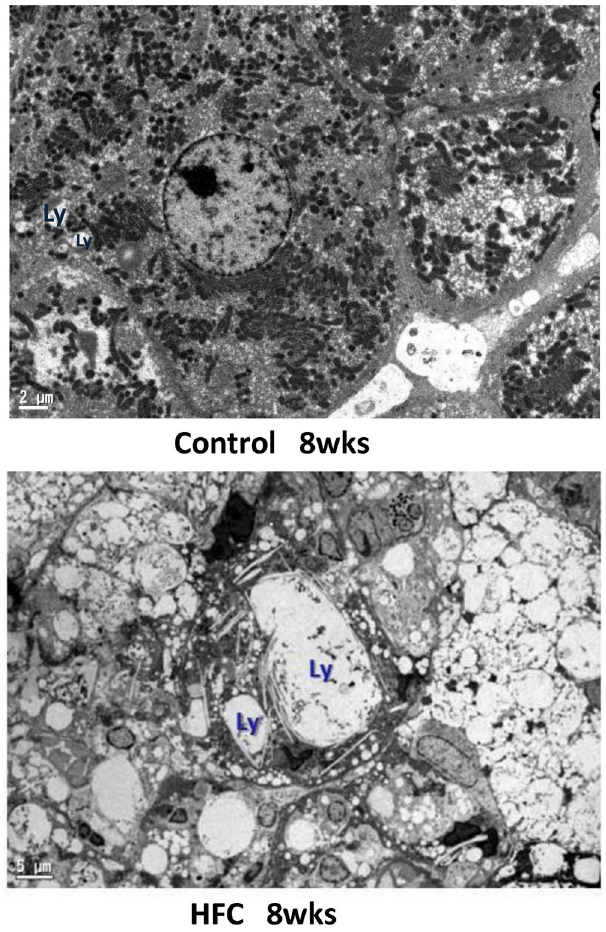
Figure 3. Electron microscopic image. Giant lysosomes ( arrow ) and accumulation of autophagosomes (top- right), related to autologous cells with heterochromatin that adhered to the nuclear membrane, are seen in the livers of rats fed the HFC diet for 8 weeks. Scale bar 2 μ m (control-diet group) and 5 μ m (HFC-diet